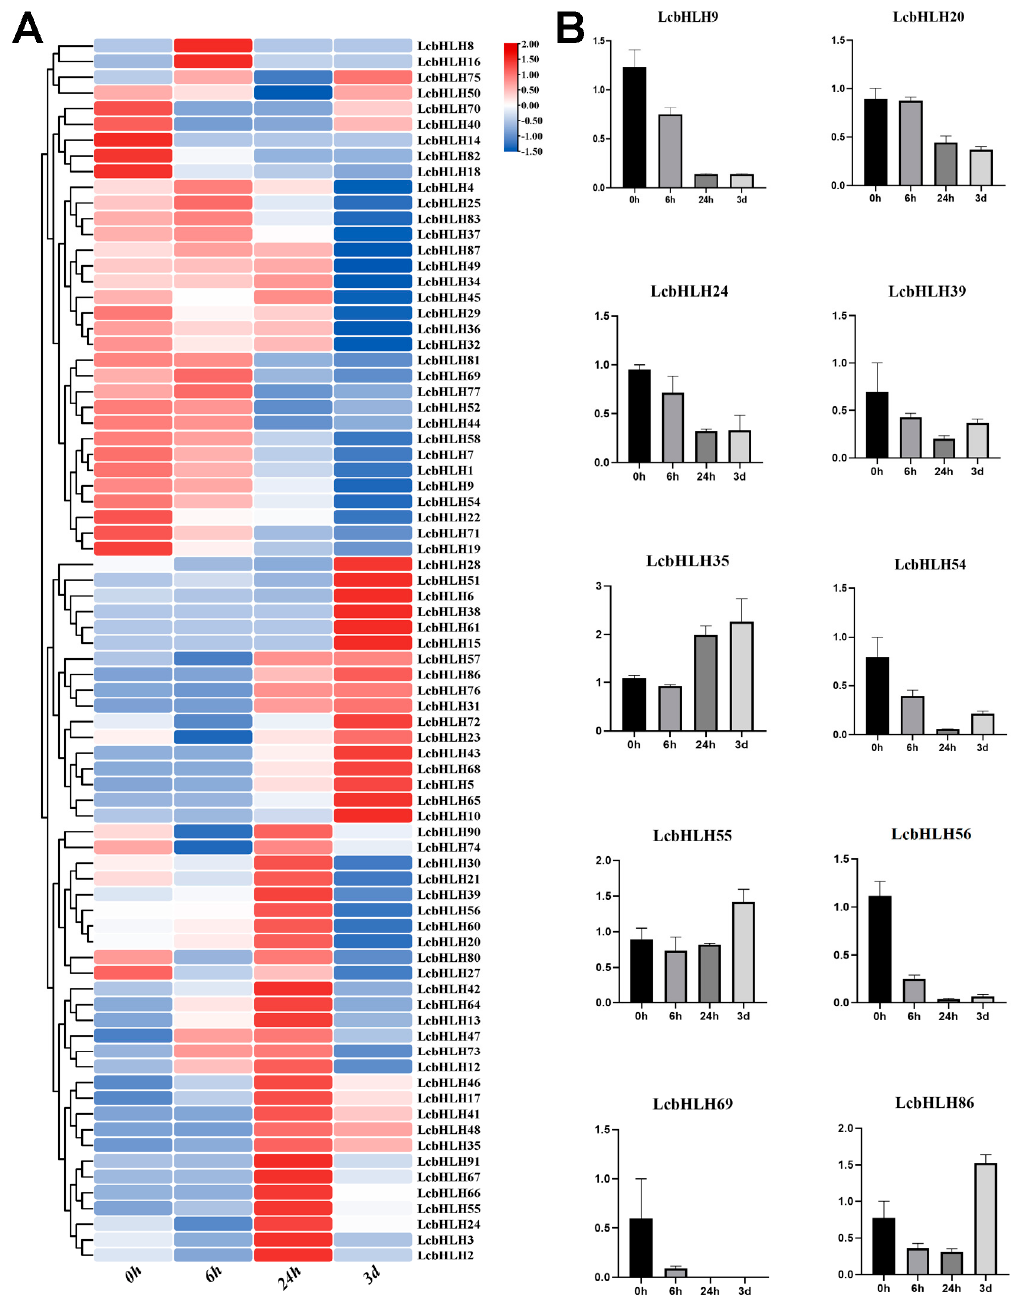
Figure 8. Expression analyais of LcbHLH genes in response to cold stress. ( A ) Transcriptomic expression analysis of LcbHLH genes. ( B ) Expression analysis of LcbHLH genes by qRT-PCR. 0h, 6h, 24h and 3d represent the treatment times of cold stress.